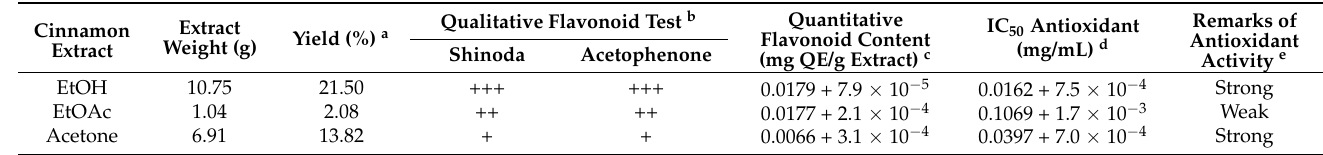
Table 2. Solvent screening for preparation of large-scale plant